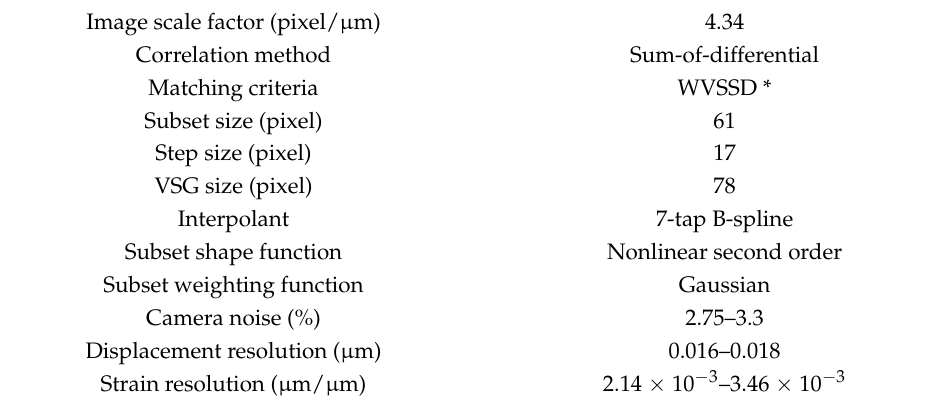
Table 2. µ DIC processing parameters used for both strain rate